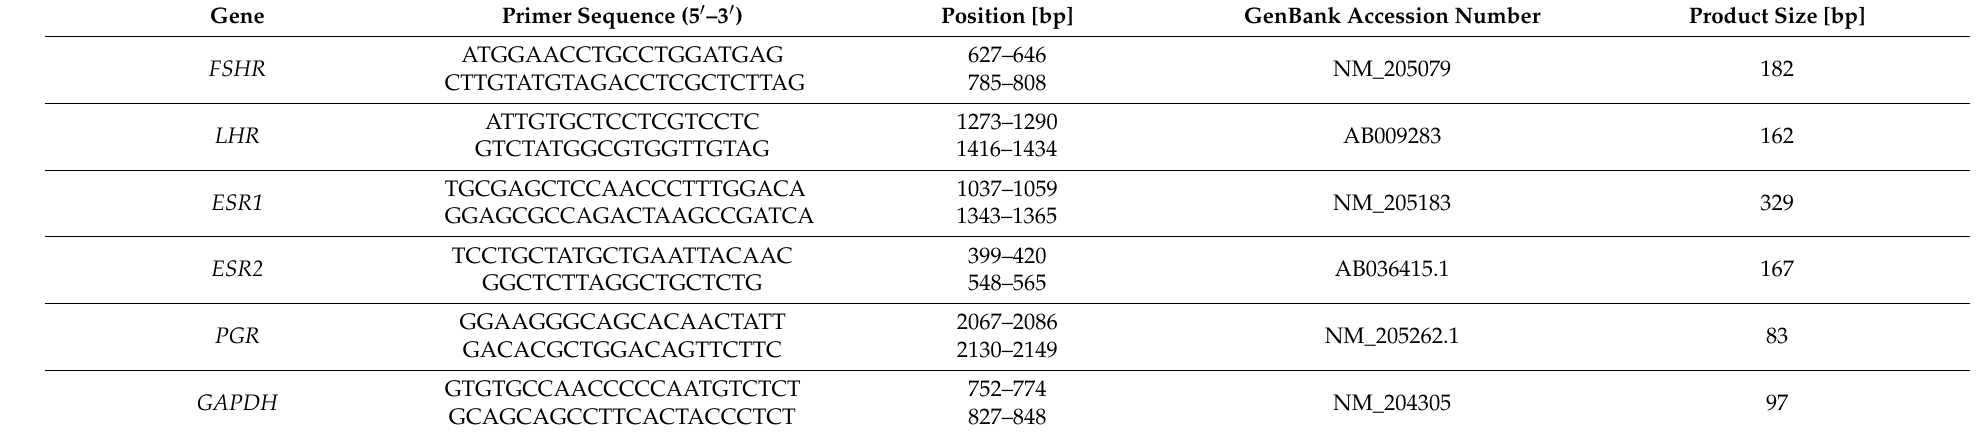
Table 1. Positions of oligonucleotide primers in mRNA sequence, GenBank accession numbers, sequences of amplified gene primers, and PCR reaction product size.